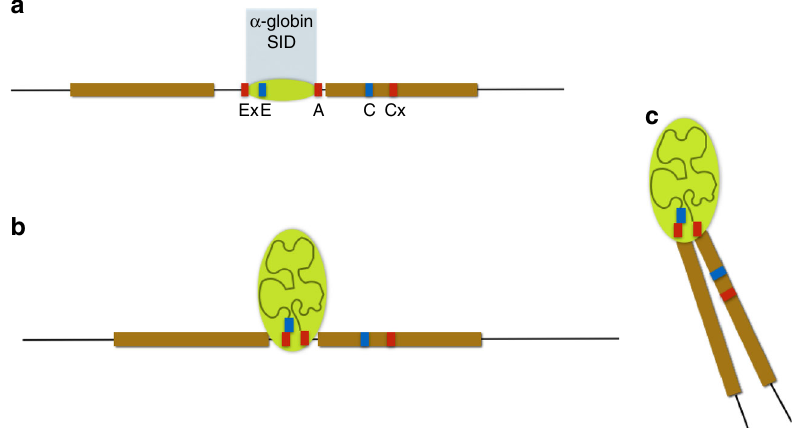
Fig. 6 A schematic model of the alpha globin locus. Schematic model showing the α -globin self-interacting domain (SID) (lime green). Sites detected by FISH probes are as for Fig. 1. a represents the linear locus, while b and c depict conformations of the self-interacting domain, where the domain expands as chromatin decompacts and the fl anking regions can sit in